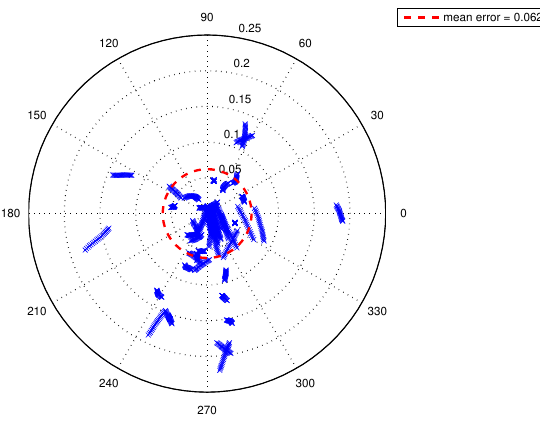
Figure 17. Distribution of EKF localization error